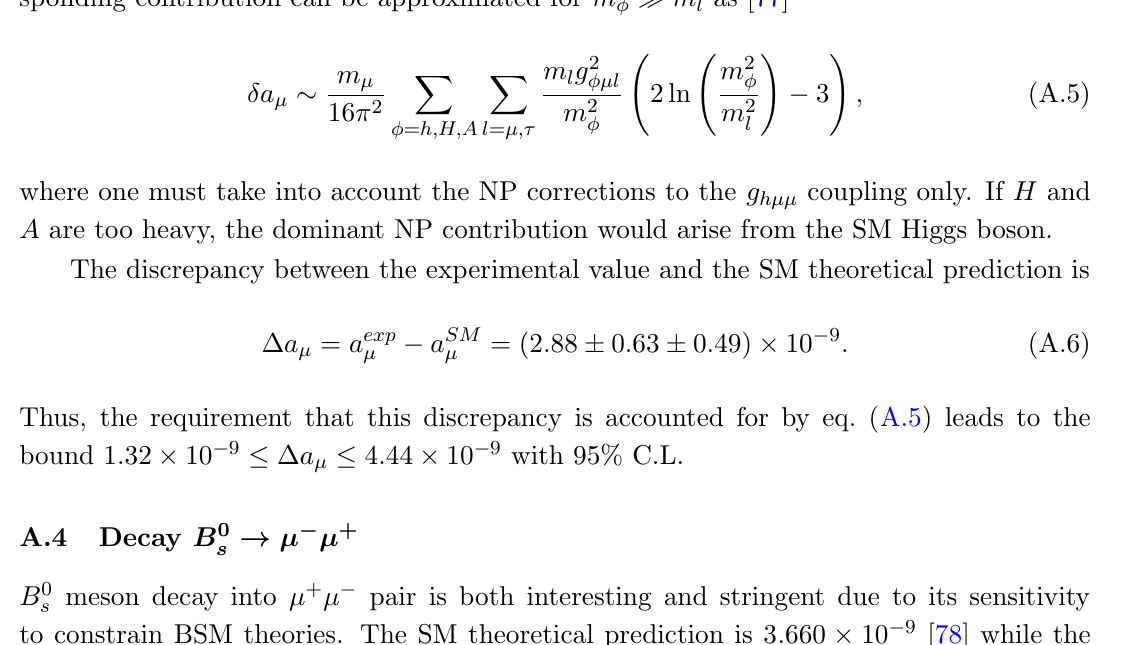
Figure 12 . Feynman diagram for the decay B 0